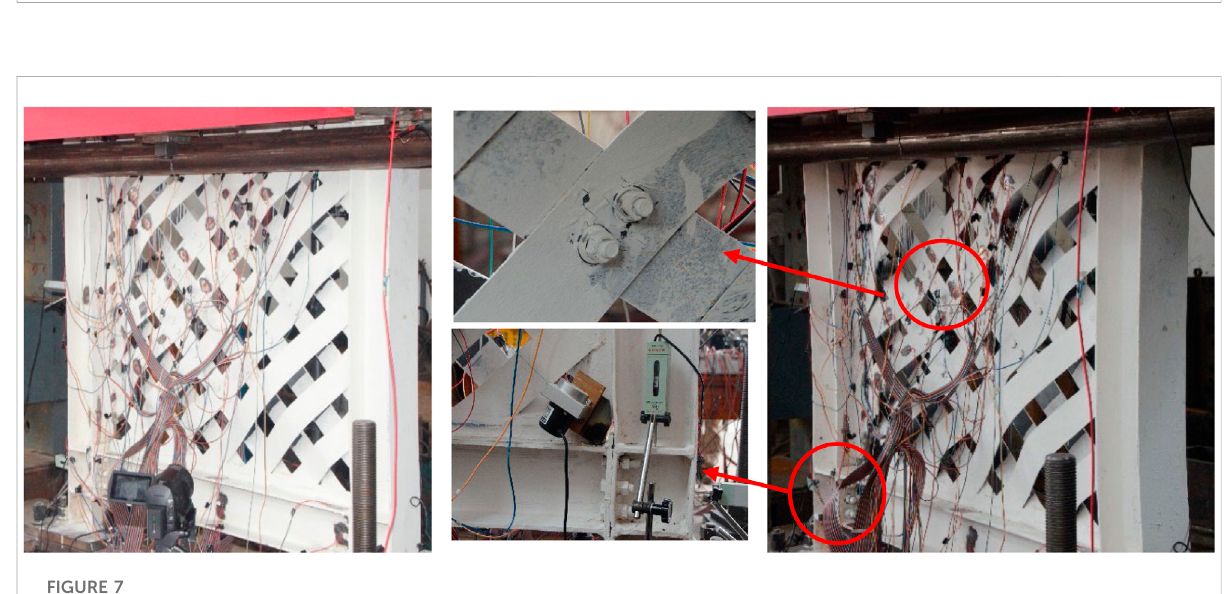
FIGURE 6 Failure phenomenon of USPSW specimen.